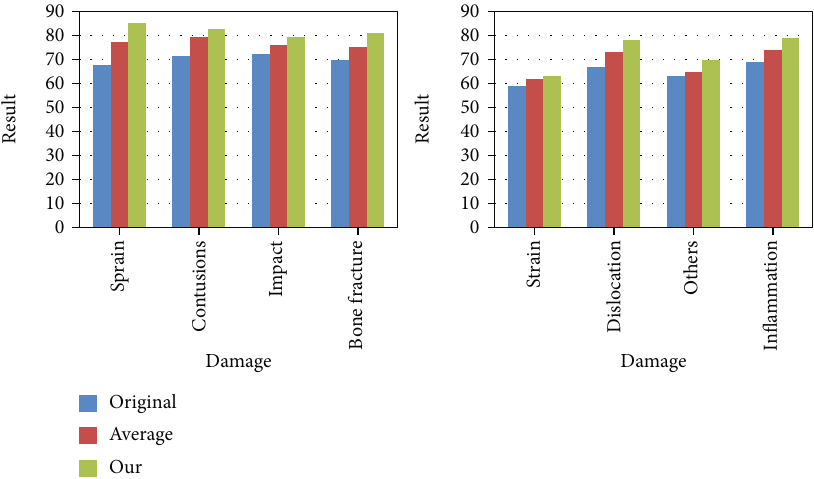
Figure 6: Detection rate of injuries in di ff erent parts of